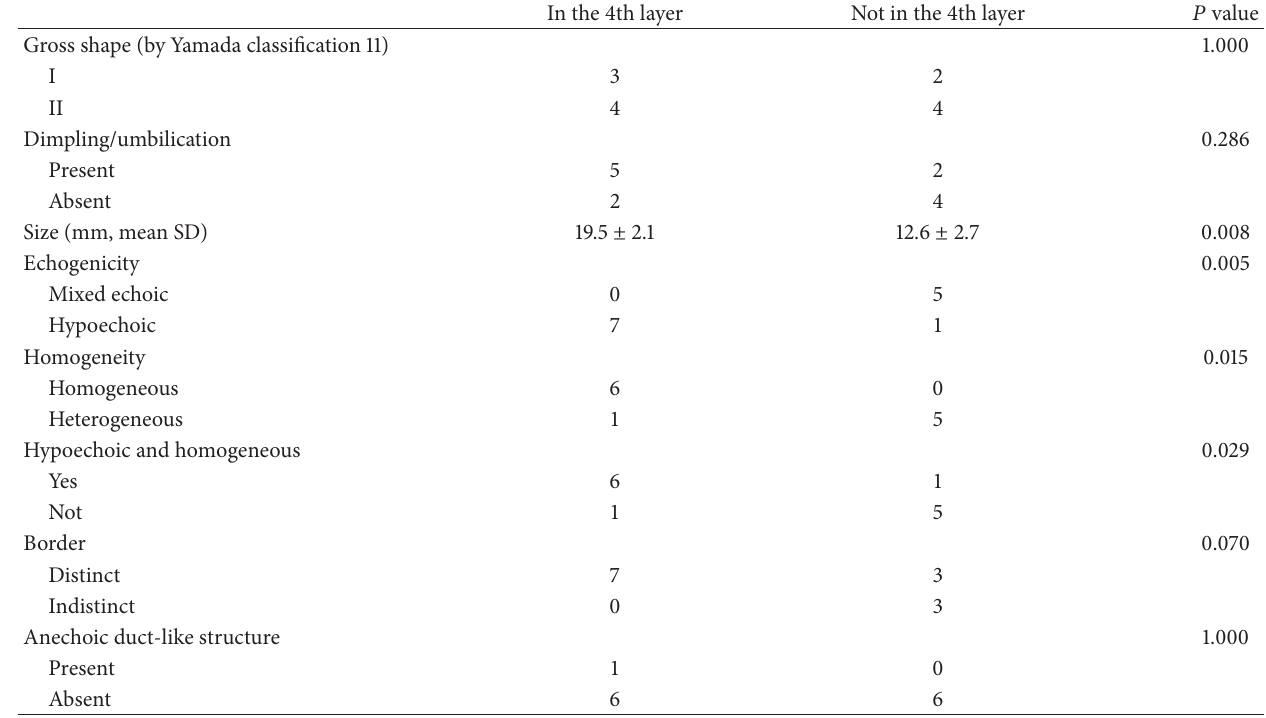
Table 3: Endoscopic ultrasonographic features of 13 patients with gastric ectopic pancreas originating in the fourth sonographic layer or